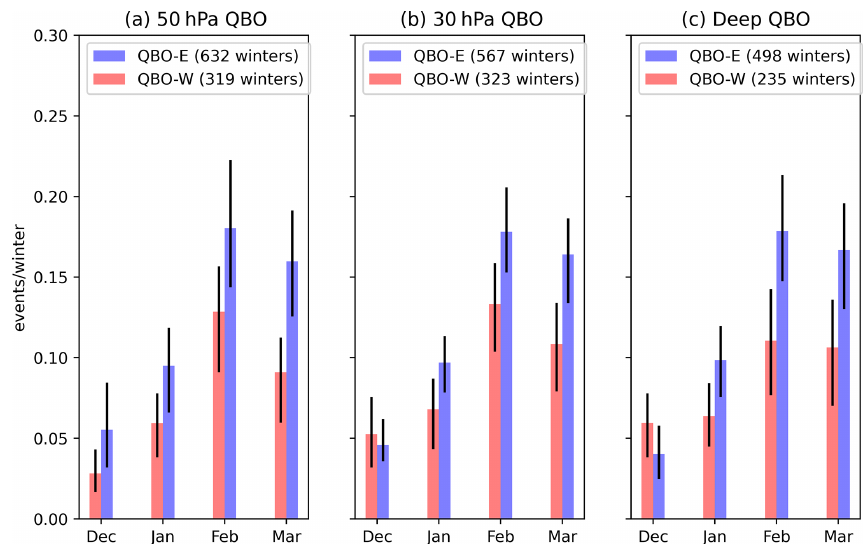
Figure 5. SSWs per winter season for years exhibiting QBO-E and QBO-W conditions in early winter (September–November) defined on different pressure levels (a, b) as well as using the deep metric (c) , the vertical mean between 15 and 30hPa defined in Andrews et al. (2019). The QBO phase is defined as any September–November equatorial (5 ◦ S–5 ◦ N average) ZMZW that exceeds a magnitude of 5ms − 1 . Error bars on all plots are derived using the same bootstrapping method outlined in Fig. 1.